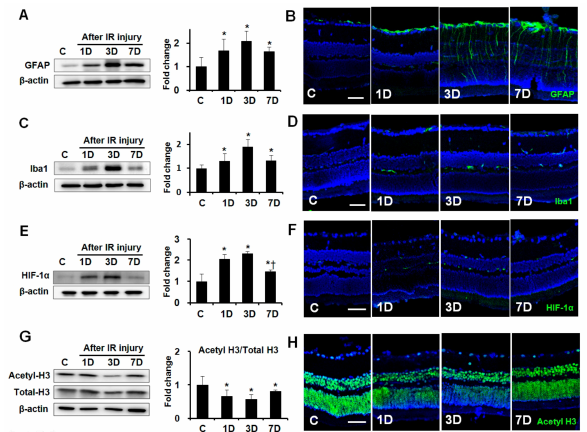
Figure 1. Expression of GFAP, Iba1, HIF-1 α , and acetyl-H3 in ischemic retinas according to time interval. Representative cropped western blots depicting GFAP, Iba1, HIF-1 α , acetyl-H3, and total-H3 protein